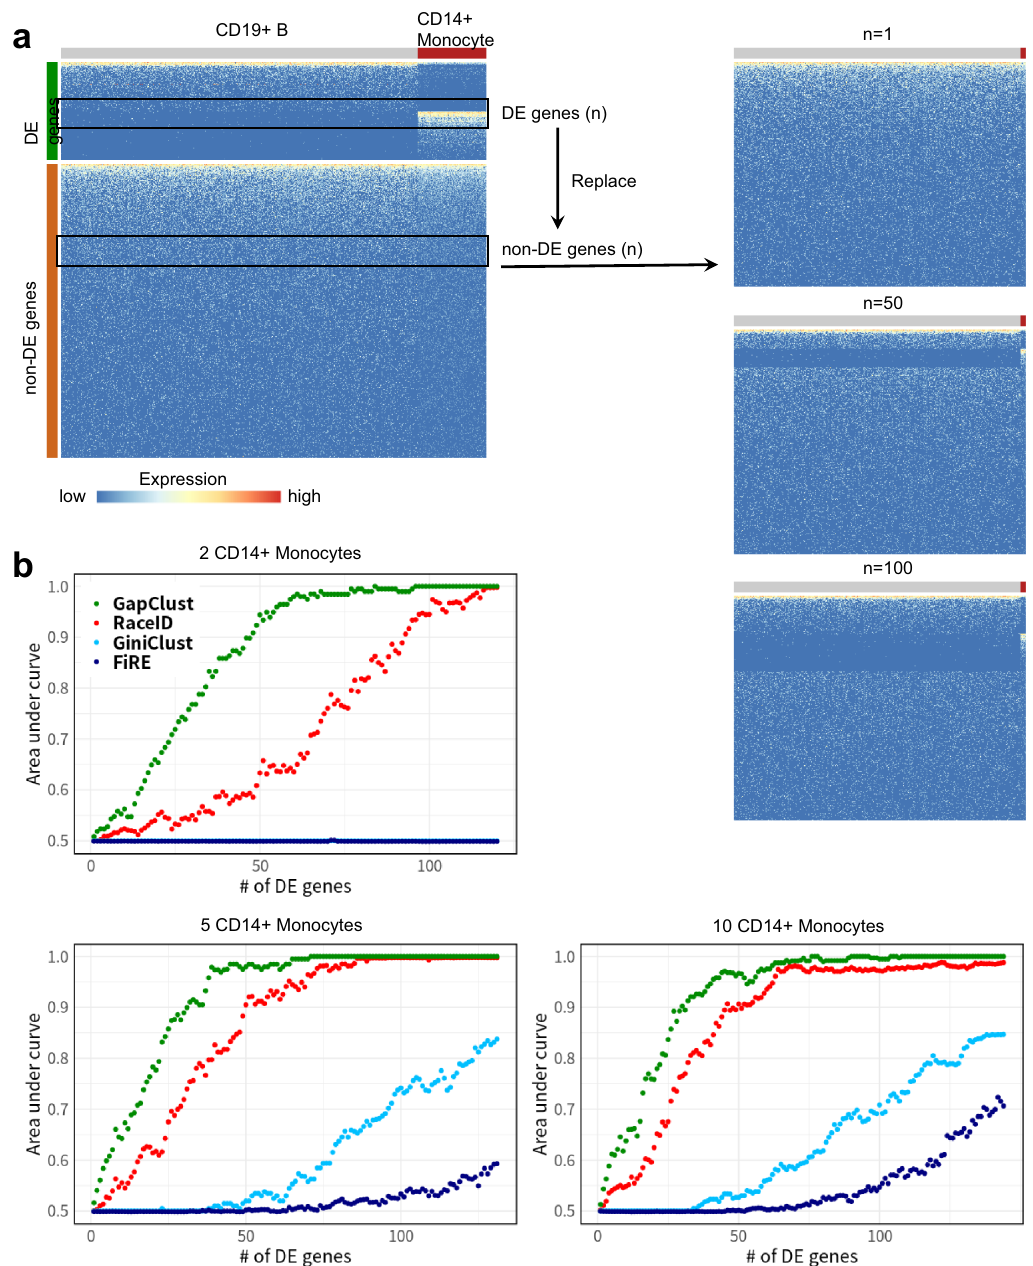
Fig. 3 Benchmarking on the sensitivity of different approaches to cell-type identity. a Schematic overview of dataset perturbations. Starting from two cell types within the 68 k PBMC dataset (abundant CD19 + B cells and rare CD14 + monocytes), we fi rstly generated three datasets by subsampling 2, 5 and 10 monocytes and 500 B cells. Differentially expressed (DE) genes between two cell types were selected through a stringent criterion for each dataset, respectively. We replaced a fi xed number of non-DE genes by the pre-identi fi ed DE genes. The count of replaced genes varied between 1 and the total number of DE genes. b The comparison of sensitivity of different methods to cell-type identity while varying the number of DE genes